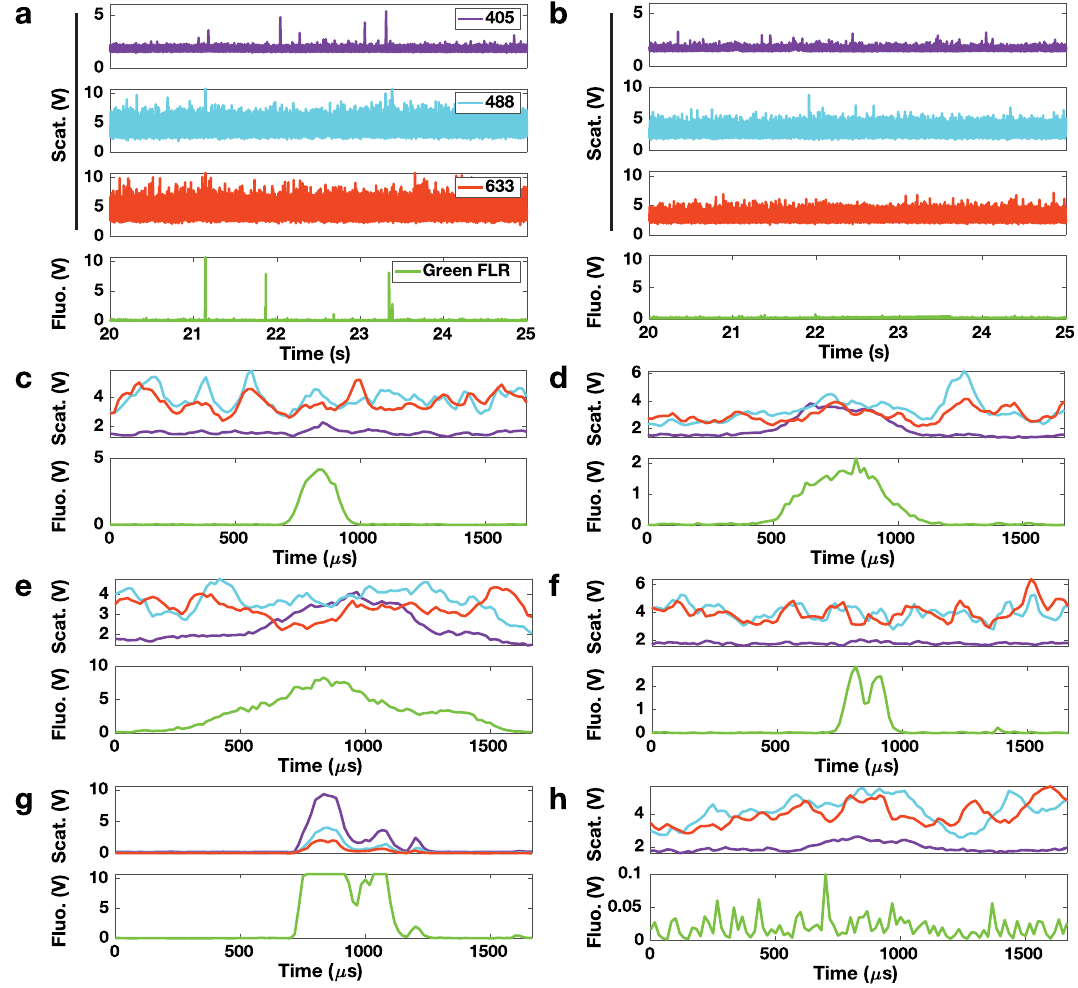
Figure 2. Raw data traces of CTCs/CTCCs and false positive events detected in sample. ( a ) A 5-s-long time trace of scattering and fluorescence signals collected from a whole blood sample spiked with CTCs/CTCCs and ( b ) an unspiked whole blood sample from the same animal. ( c ) A single CTC with a narrow FWHM (11 points) suggesting this belongs to an individual cell. ( d ) A small CTCC with a peak width of 24 points representing a small cluster 3–4 cells in size. ( e ) A large CTCC with a peak width of 30 points representing a large cluster 6+ cells in size. These events are labeled as CTCs/CTCCs based on their broad peak widths and green fluorescence signal, which is being used as our ground truth label. ( f ) Shows a peak event with a strong green fluorescence signal with no clear scattering signal. ( g ) A local trace from a 3–4 cell cluster with a peak width of 24 points from flowing CTCCs in cell growth media. ( h ) A local trace from an event that is incorrectly labeled as a CTCC by the initial peak detection peaks, relying on the GFP-detected peaks as the gold standard. The machine learning model was composed of two parts—the first part was an initial peak detection algorithm; the second part was a classification algorithm. During each experiment, data were acquired from ~ 135 μL of spiked blood samples, collected typically over 45 min. A second order Butterworth filter was applied to the detected scattering and fluorescence signals (Fig. 3a) to remove high frequency noise, before data from the three scattering channels was normalized based on daily power measurements and a 99% reflectance standard (Fig. 3b). Following a previously established data analysis workflow, signals from the three scattering channels were summed together, while the green fluorescence signal was processed independently (Fig. 3c) 9 . Peak locations were determined using the built-in MATLAB func- tion findpeaks.m in the same step. An intensity threshold (3σ) was used to define peak event ranges based on where the cumulative scattering and FP1 only traces crossed the threshold value (Fig. 3d). Each peak range was inspected to determine if multiple peaks were located within a single range. If multiple peak events were found within the same peak range, only the maximum peak was saved; all other peaks in the range were deleted. Any peak that failed to cross the 3σ threshold was also deleted and assumed to be a noise event. The peak detection algorithm extracted characteristics from the remaining peaks such as peak width, area-under-the-curve, loca- tion, and intensity (Fig. 3e). While all these peak metrics were calculated and stored, for the studies discussed here, only peak width and location were used. This marked the end of the peak detection algorithm. Prior to